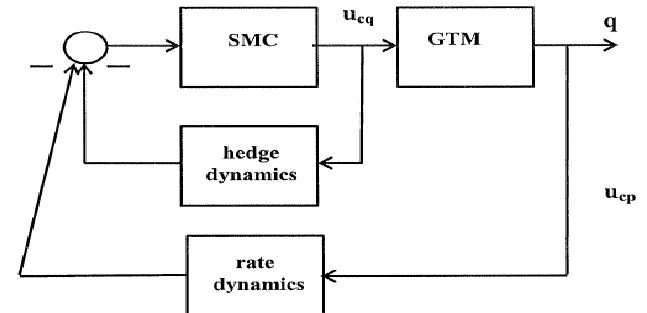
Figure 5. Hedge and rate dynamics placement.